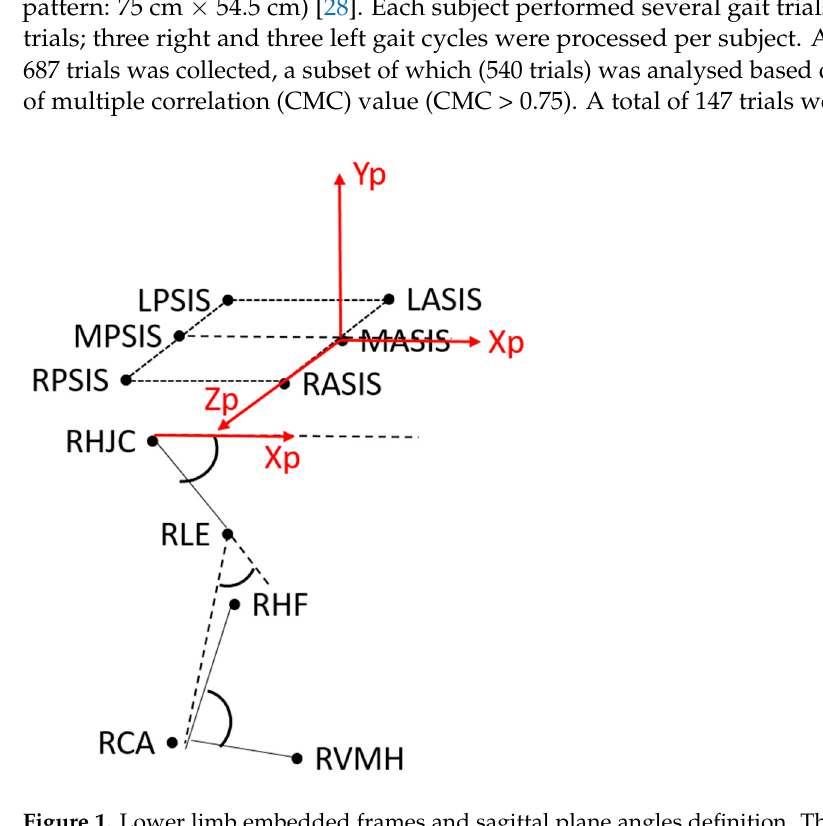
Figure 1. Lower limb embedded frames and sagittal plane angles definition. The pelvis reference system is represented in red: the origin is the midpoint between LASIS and RASIS (MASIS), the z axis is the normalized vector oriented as the line passing through the LASIS and RASIS with its positive direction from left to right; the x axis lies in the plane defined by the RASIS, LASIS and the midpoint between the RPSIS and LPSIS (MPSIS) with its positive direction forwards; the y axis is orthogonal to the xz plane and its positive direction is proximal. The hip flexion angle is defined as the angle between pelvis and femur (femur is the line connecting the hip joint centre (HJC) and the lateral epicondyle (LE)); the knee flexion angle is defined as the angle between femur and shank (shank is the line connecting the LE and the calcaneus (CA)); the ankle flexion angle is defined as the angle between shank and foot (foot is the line connecting the CA and the fifth metatarsal head (VMH)). The following acronyms were used: right and left anterior superior iliac spines (RASIS, LASIS); right and left posterior superior iliac spines (RPSIS, LPSIS); right and left lateral epicondyles (RLE, LLE); right and left heads of fibula (RHF, LHF); right and left calcanei (RCA, LCA); right and left fifth metatarsal heads (RVMH, LVMH); right and left HJC (RHJC, LHJC).